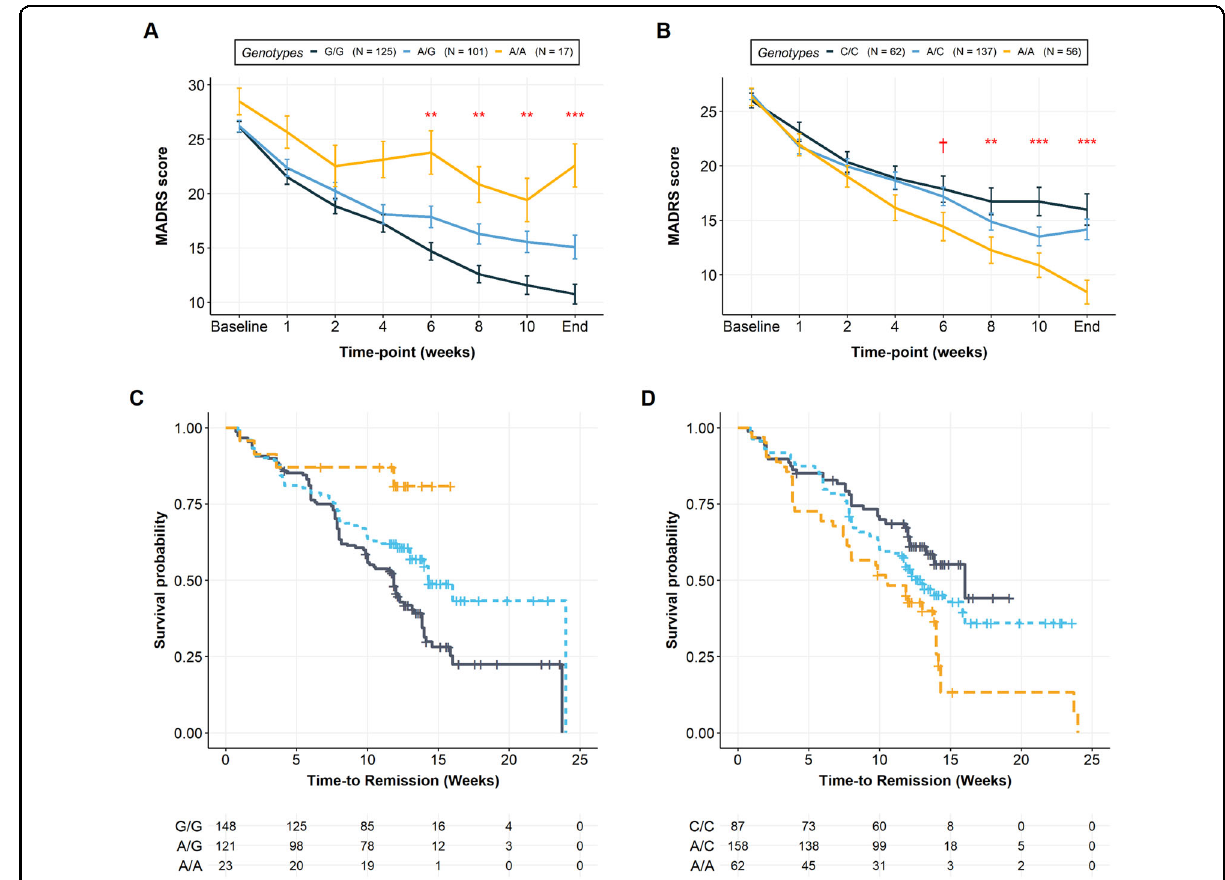
Fig. 3 Secondary analysis results for top-associated SNPs, rs6916777 (chr6:25251374:C:A) and rs12597726 (chr16: 88820301:G:A). A, B Mixed-effects analyses for rs6916777 and rs12597726, respectively. Values at each time-point denote mean per genotype, and error bars denote standard error of the mean. C, D Kaplan – Meier survival plots for rs6916777 and rs12597726, respectively. Risk tables denote the number of non- remitted or censored individuals at each time-point. Signi fi cance levels. *** p < 0.001, ** p < 0.01, * p < 0.05, † p <